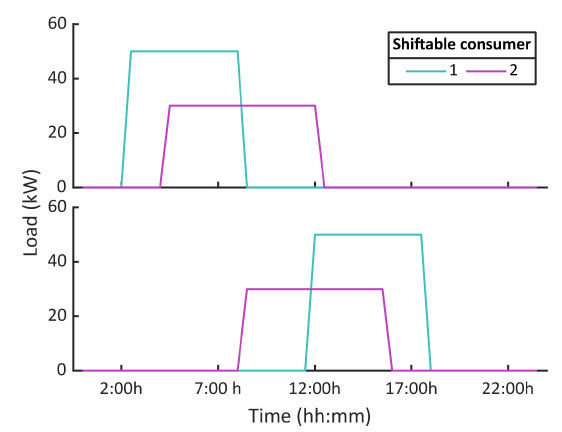
Figure 13. Scheduling result of the shiftable consumer with model 1 ( upper ) and 2 ( bottom